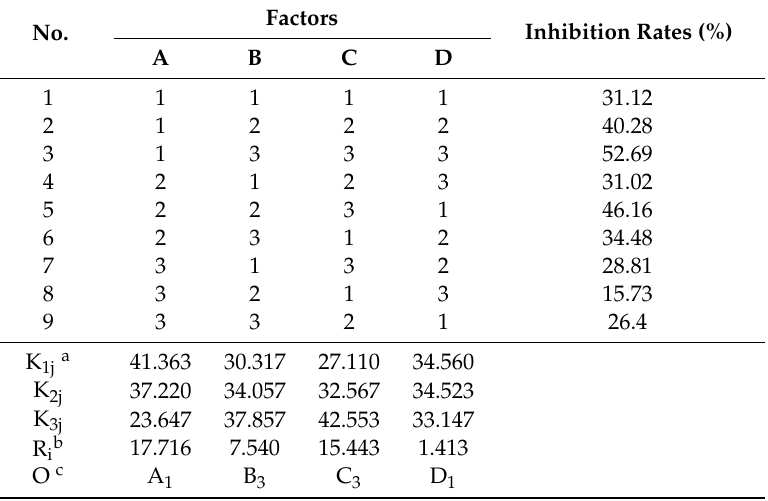
Table 2. Arrangement and results of L 9 (3 4 ) orthogonal